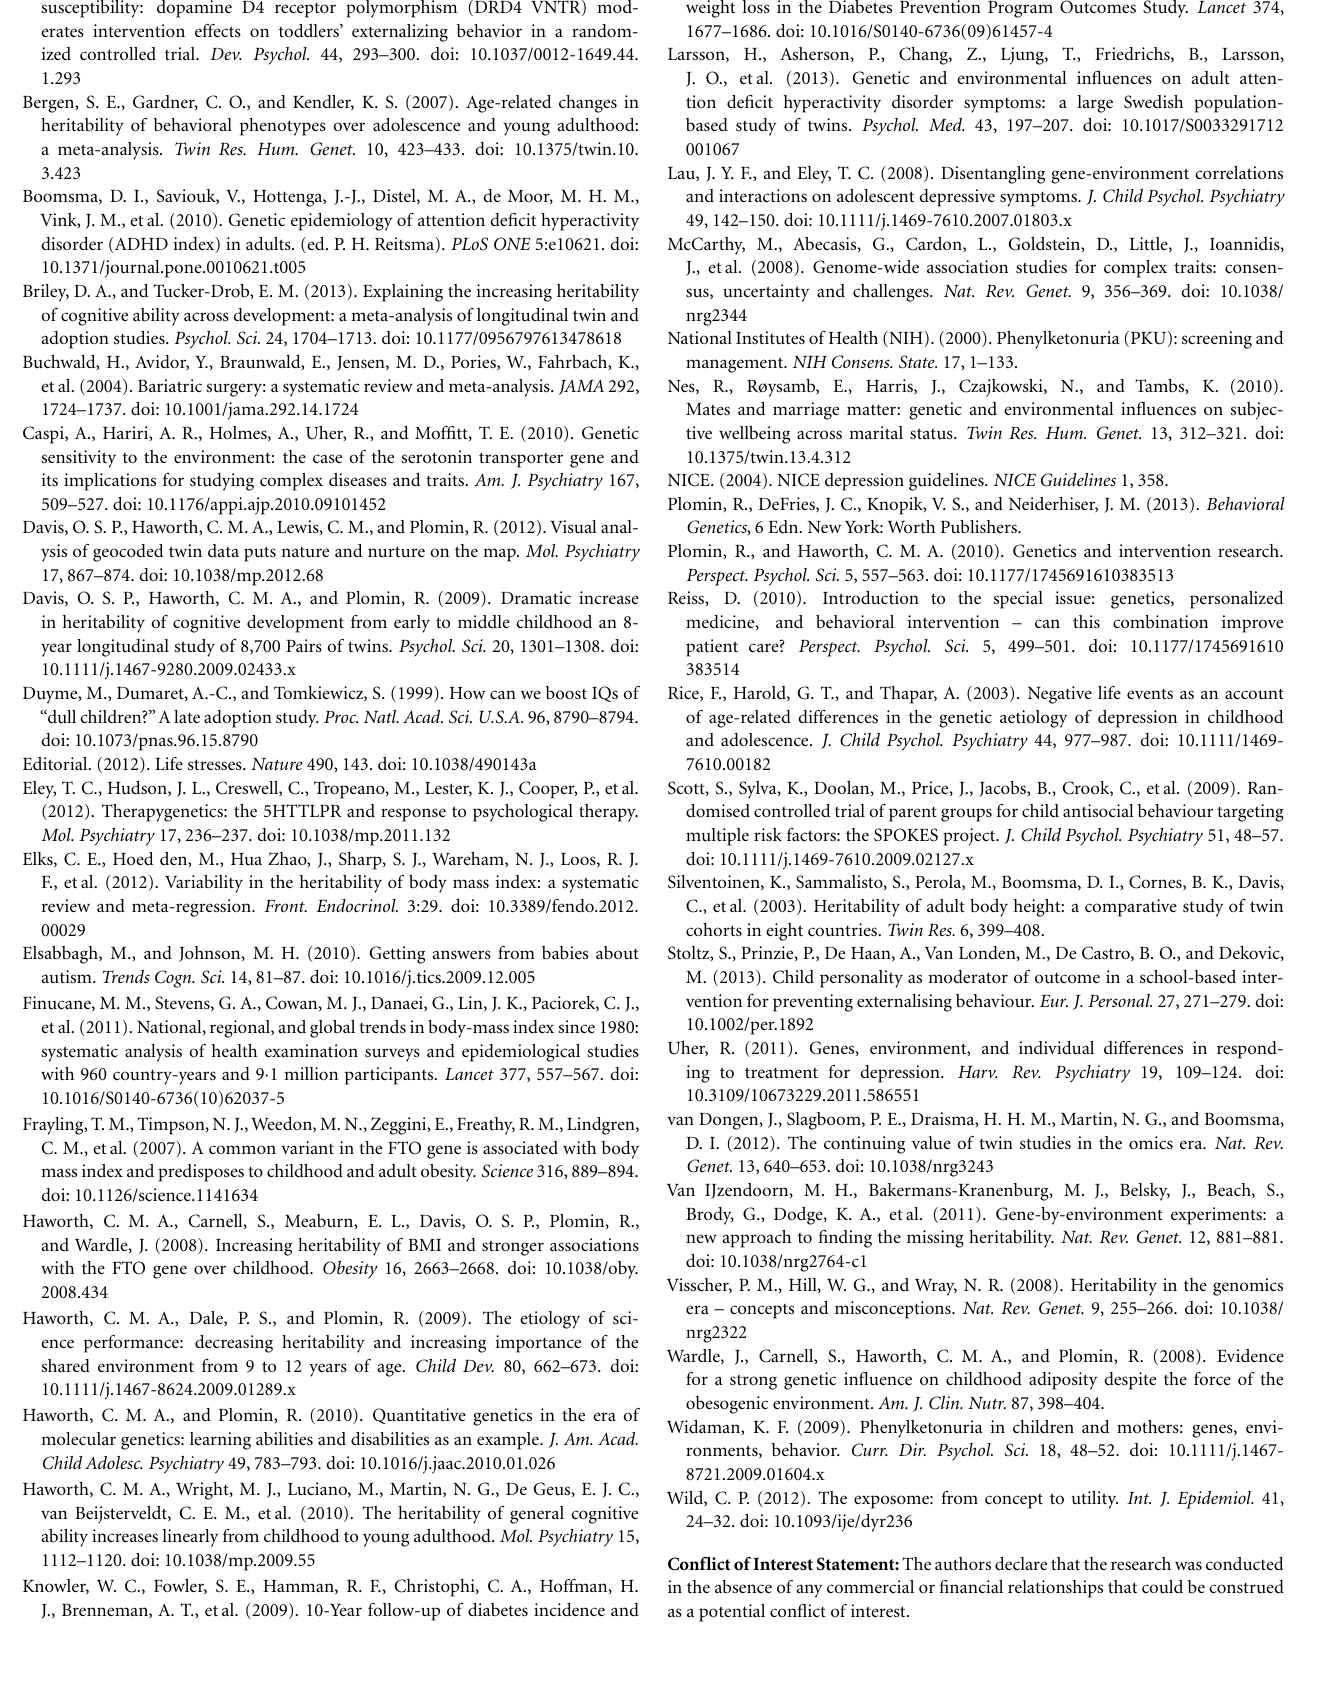
as a potential conflict of